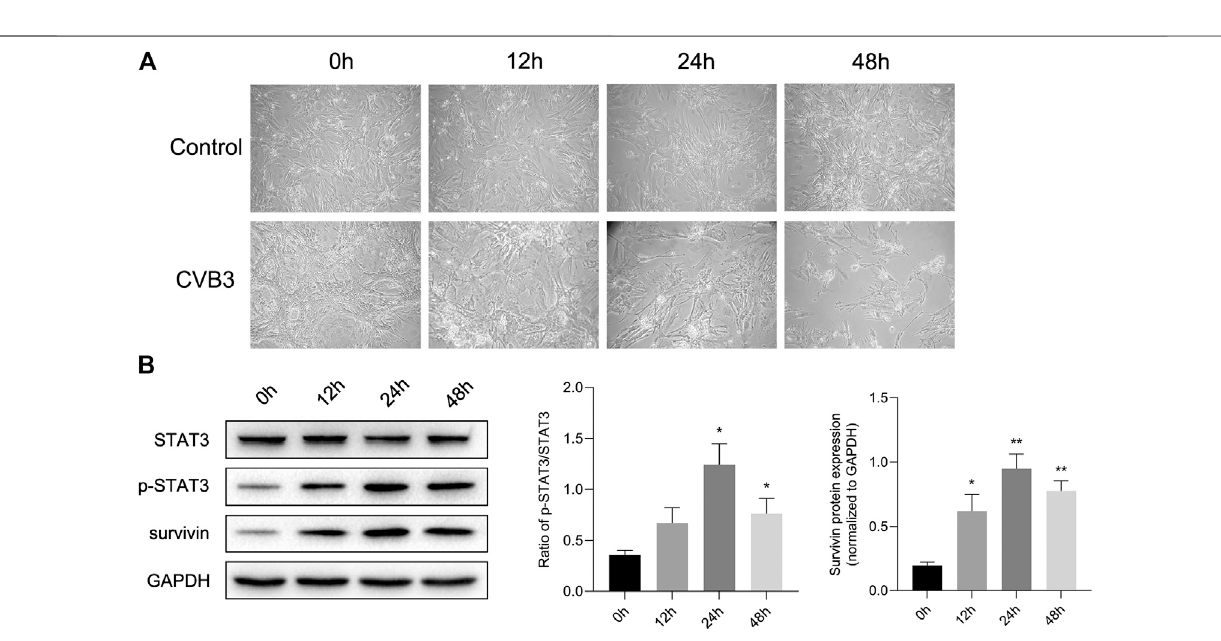
Frontiers in Pharmacology |